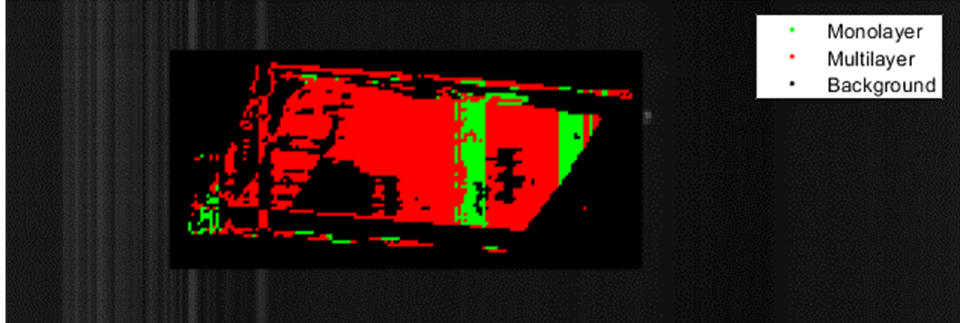
Figure 25. Classification of PE/PP multilayer film with the SNN.